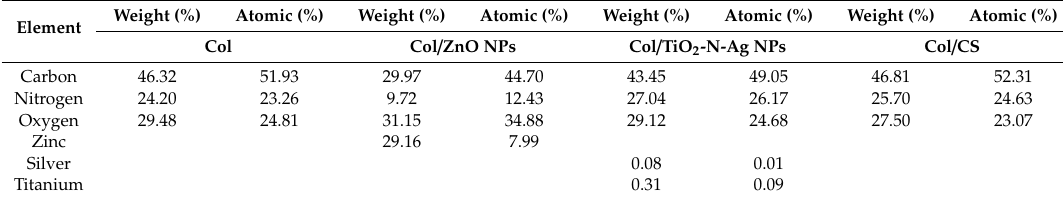
Table 3. Mass and atomic compositions for the electrospun collagen nanofibers.